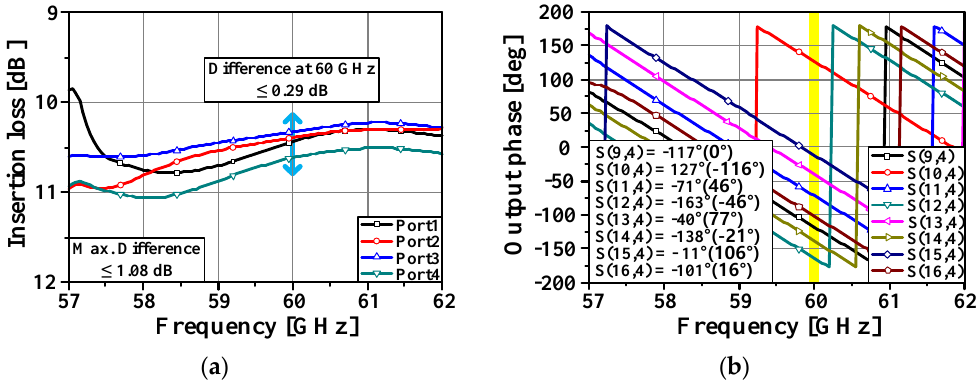
Figure 6. Simulated results of the 8 × 8 Butler matrix: ( a ) averaged insertion losses and ( b ) output phase for excitation of port 4.